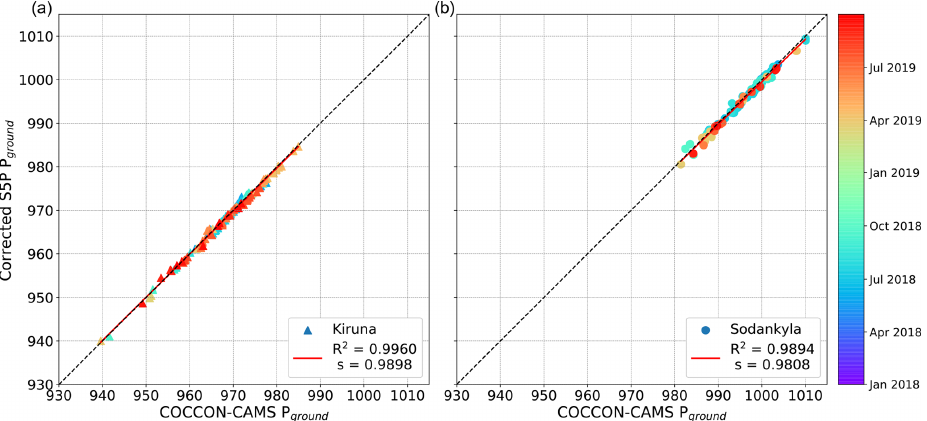
Figure 9. Ground pressure comparison between S5P and COCCON at Kiruna (a) and Sodankylä (b) . The S5P pressure is interpolated to the height of COCCON. Every point represents coincident S5P and COCCON measurements. The annotations follow those in Fig. 5. It is noted that the color bar starts from 2018 rather than 2017 to distinguish the data better.